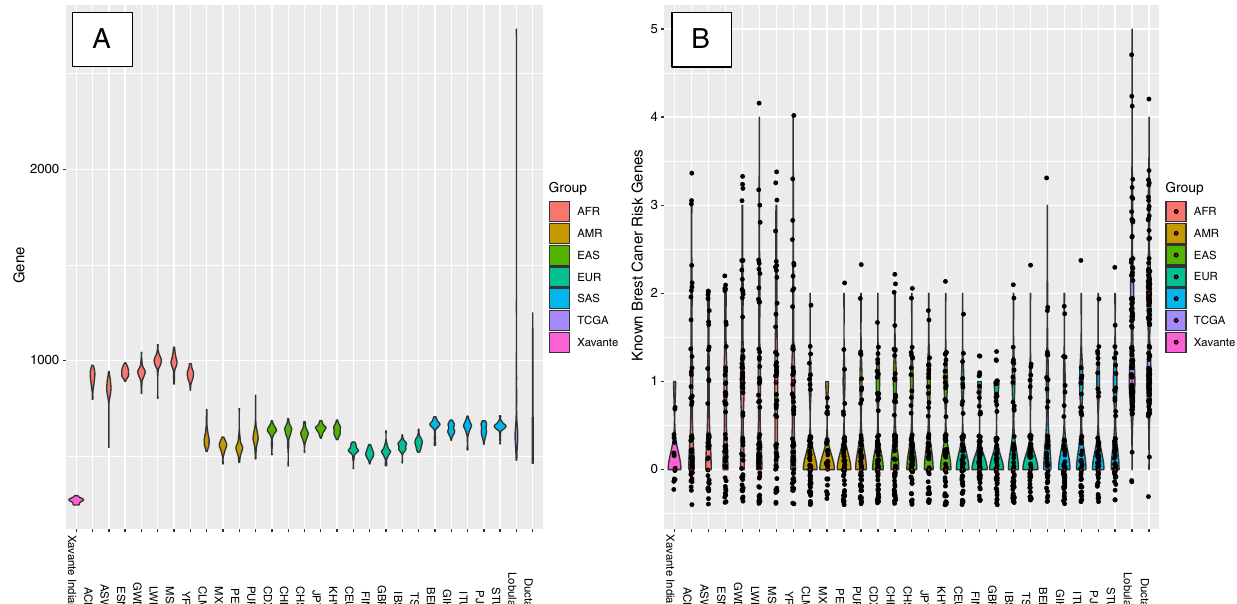
Figure 4. Violin plot of number of mutated genes affected by rare damaging variants in different populations which include Xavante Indians, normal populations from 1000 Genome Project and normal samples from TCGA breast cancer dataset. ( A ) Number of mutated genes in the whole exome (p < 0.0001 for all groups against Xavante Indians); ( B ) Number of mutated genes in the known breast cancer risk genes (p < 0.0001 for Xavante Indians vs. TCGA breast normal control